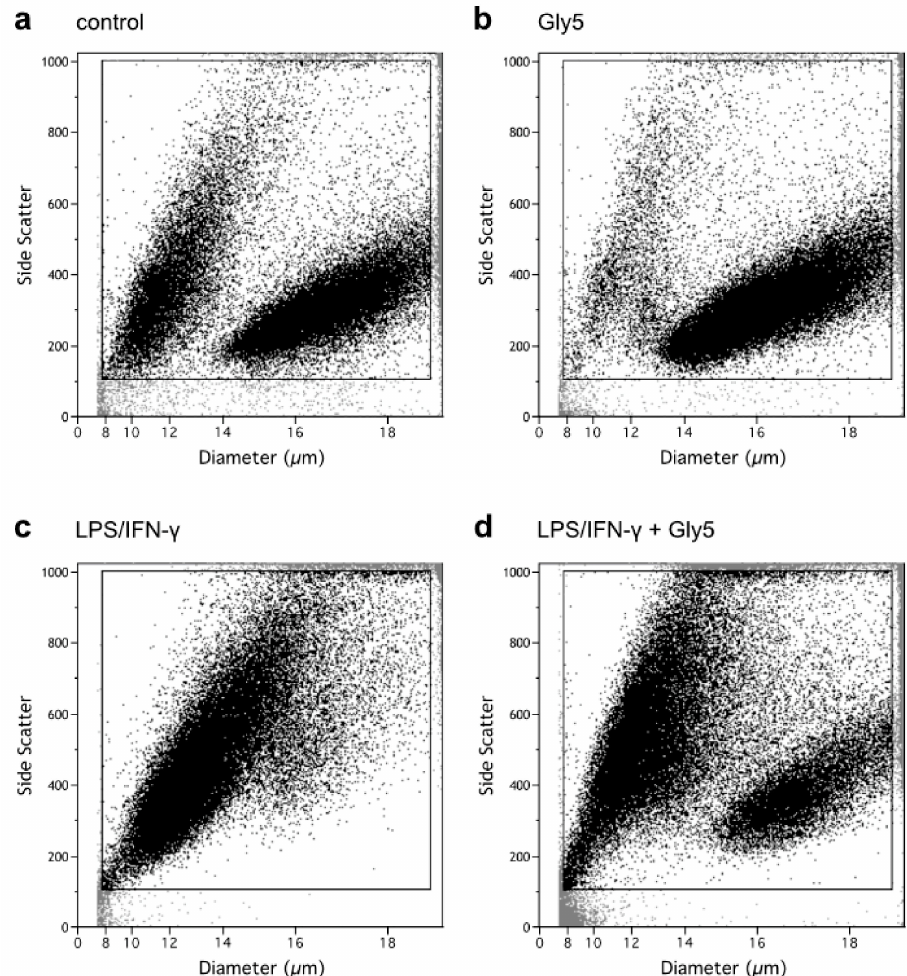
Figure 1. Side scatter vs. cell diameter ( µ m) plots of ( a ) untreated BV-2 cells, ( b ) cells treated with 5 mM glycine (Gly5), ( c ) cells treated with lipopolysaccharide / interferon- γ (LPS / IFN- γ ) alone and ( d ) cells treated with both LPS / IFN- γ and 5 mM glycine (Gly5) after 24 h of incubation. Cell counts were gated to exclude cell debris. One experiment out of six independent experiments is